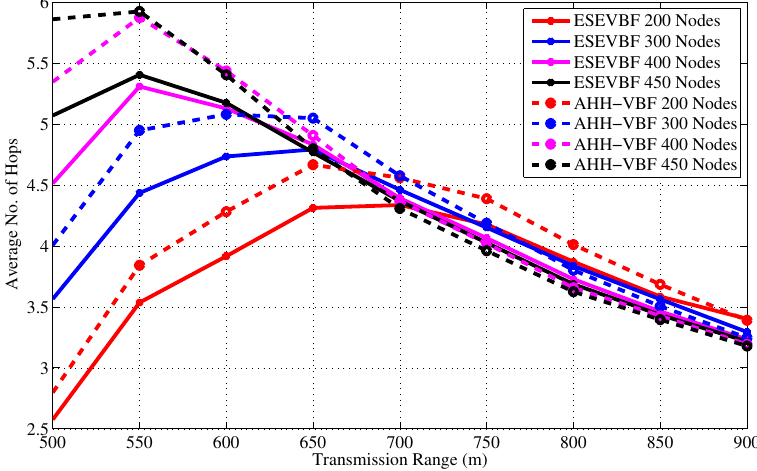
Figure 16. Average no. of hops data messages traversed versus transmission